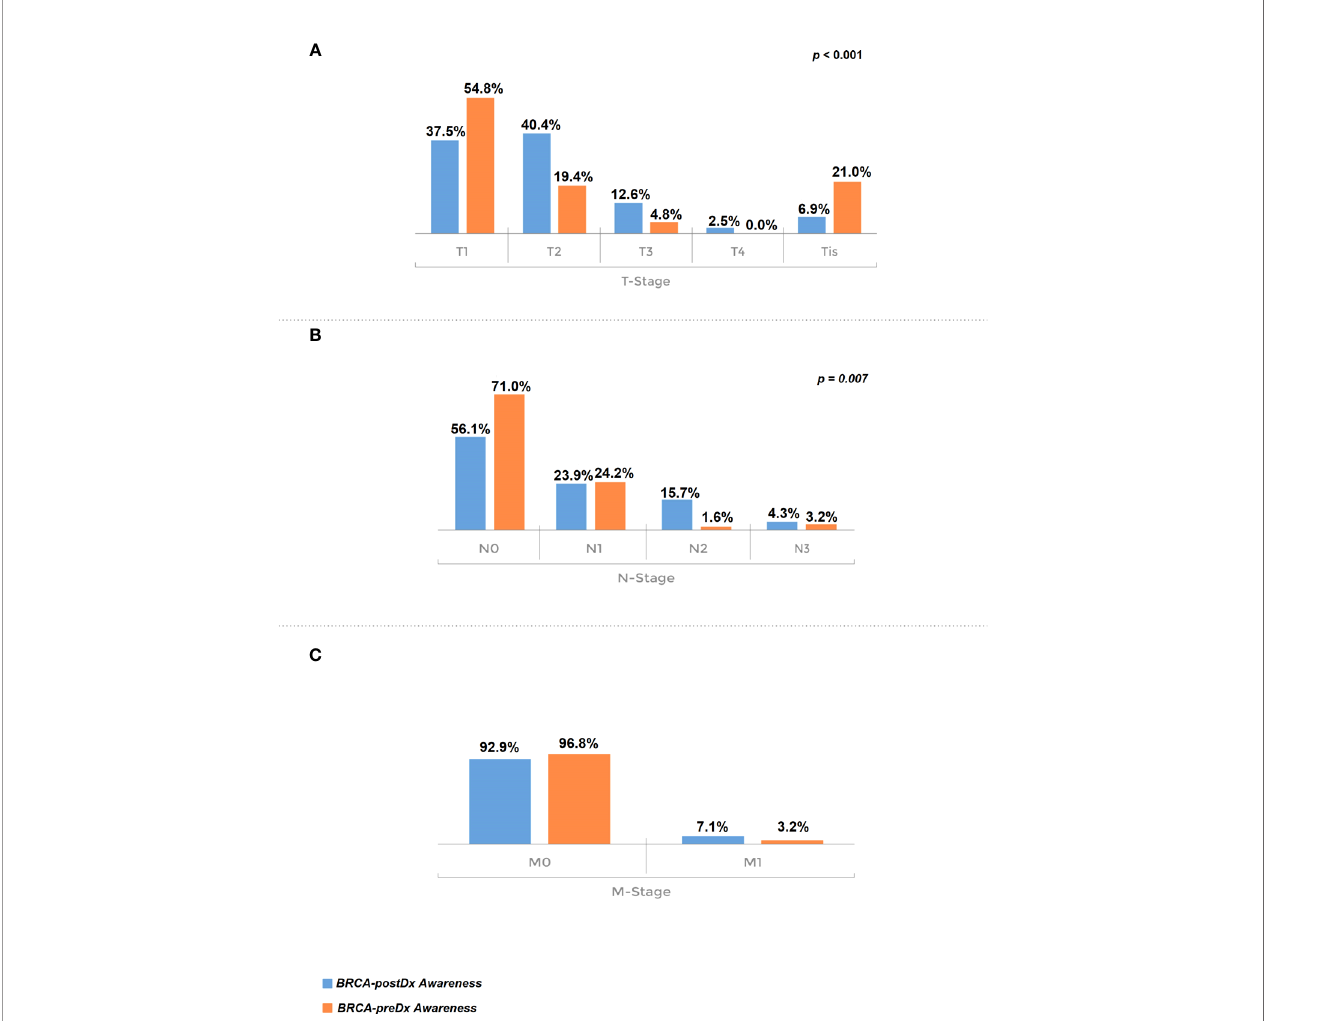
FIGURE 2 | Tumor stage at diagnosis. (A) T stage, comparison of the BRCA-preDx awareness group with the BRCA-postDx awareness group. (B) N stage: comparison of the BRCA-preDx awareness group with the BRCA-postDx awareness group. (C) M stage: comparison of the BRCA-preDx awareness group with the BRCA-postDx awareness group.